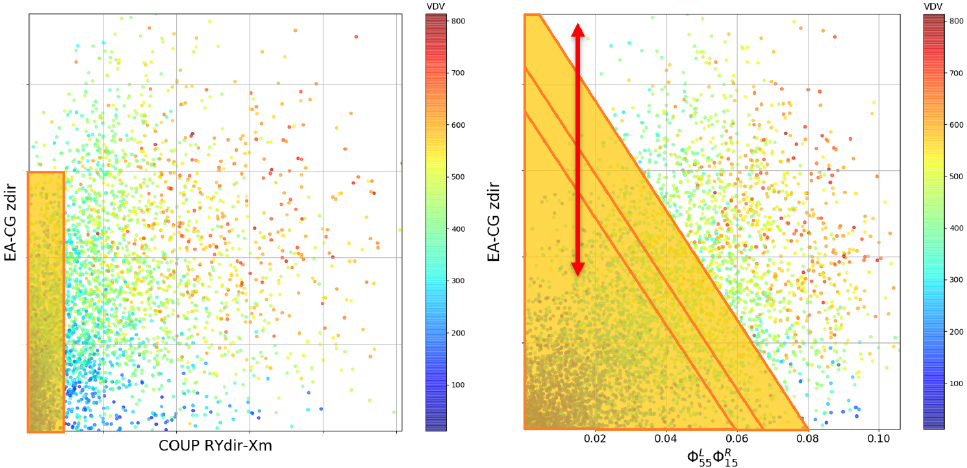
Figure 6. Comparison of the formulation of different requirements: ( left ) benchmark requirement; ( right ) new